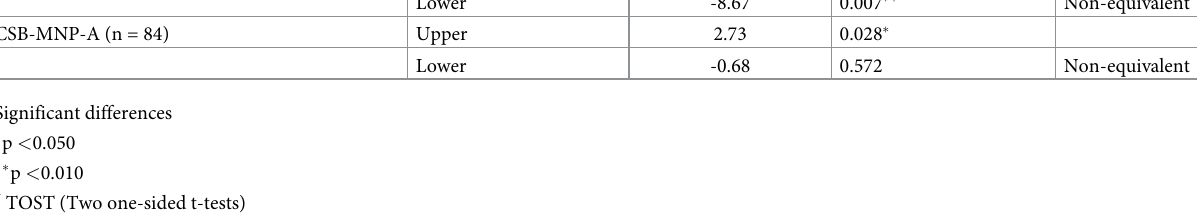
Table 4. Bioequivalence of MNPs to CSB on serum zinc concentration. Bioequivalence to CSB (n = 80) TOST † T p-value Bioequivalence CSB-MNP-C (n = 94) Upper CSB-MNP-A (n = 84) Upper Significant differences � p <